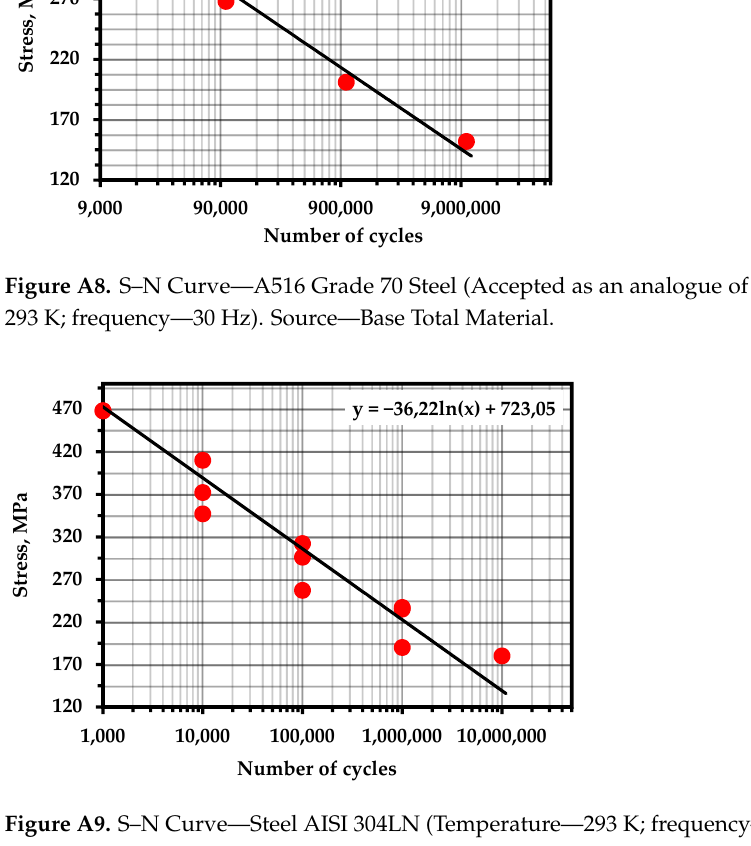
Figure A10. S–N Curve—Steel AISI 304L (Temperature—700 К ; frequency—40 Hz; R = − 1) [103]. Figure A11. S–N Curve—Steel 09G2S (Temperature—293 К ; frequency—0.6 Hz) [104].